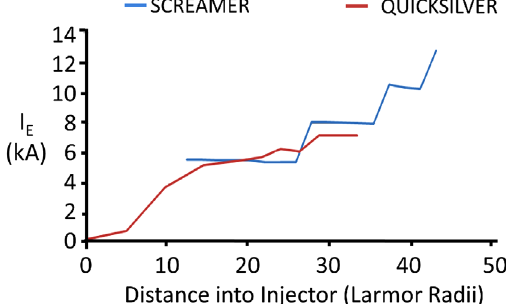
FIG. 20. The increase in the electron current (anode current minus cathode current) as a function of the distance into the CSMITL injector region at ∼ 245 ns and measured in terms of the Larmor radii at the midpoint of the injector.